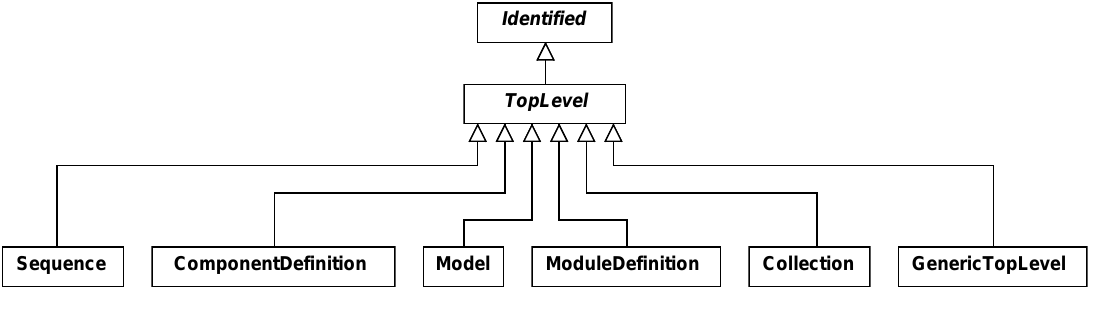
Figure 5: Classes that inherit from the TopLevel abstract